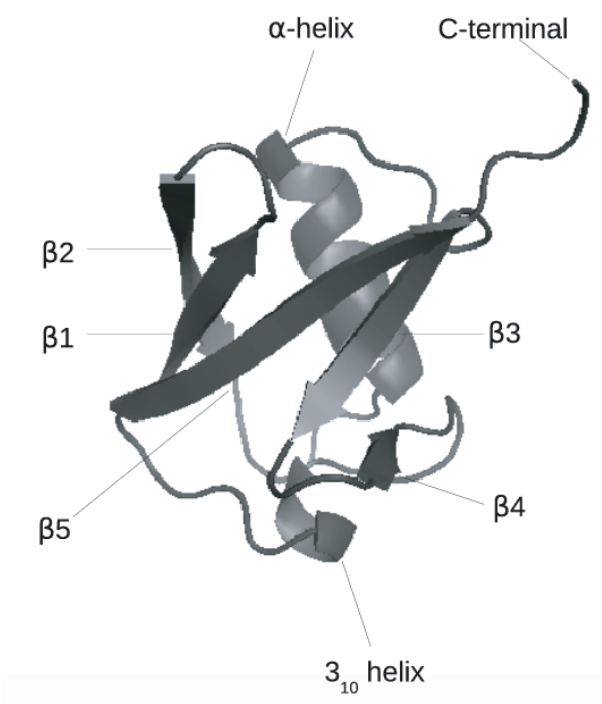
Figure 1. The native structure of ubiquitin (PDB ID: 1UBQ). The secondary structural features are